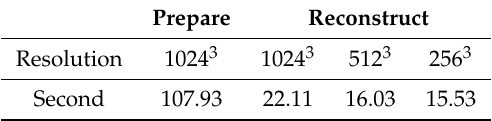
Table 3. Timing of VAPOR to prepare data in VDC format and reconstruct back to gridded data.